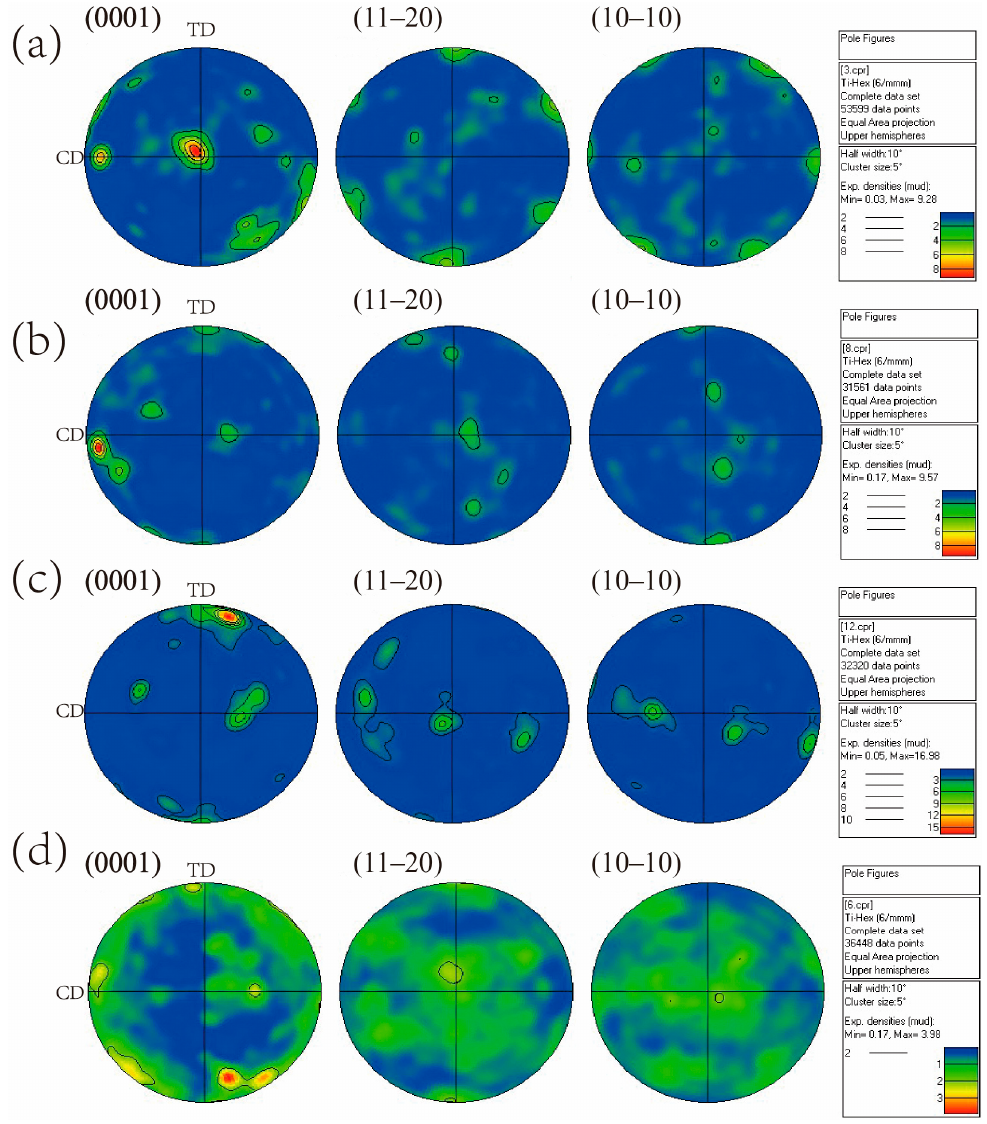
Figure 15. Pole figures of TC4 alloy after MDIF: ( a ) one cycle; ( b ) two cycles; ( c ) three cycles; ( d ) four cycles.